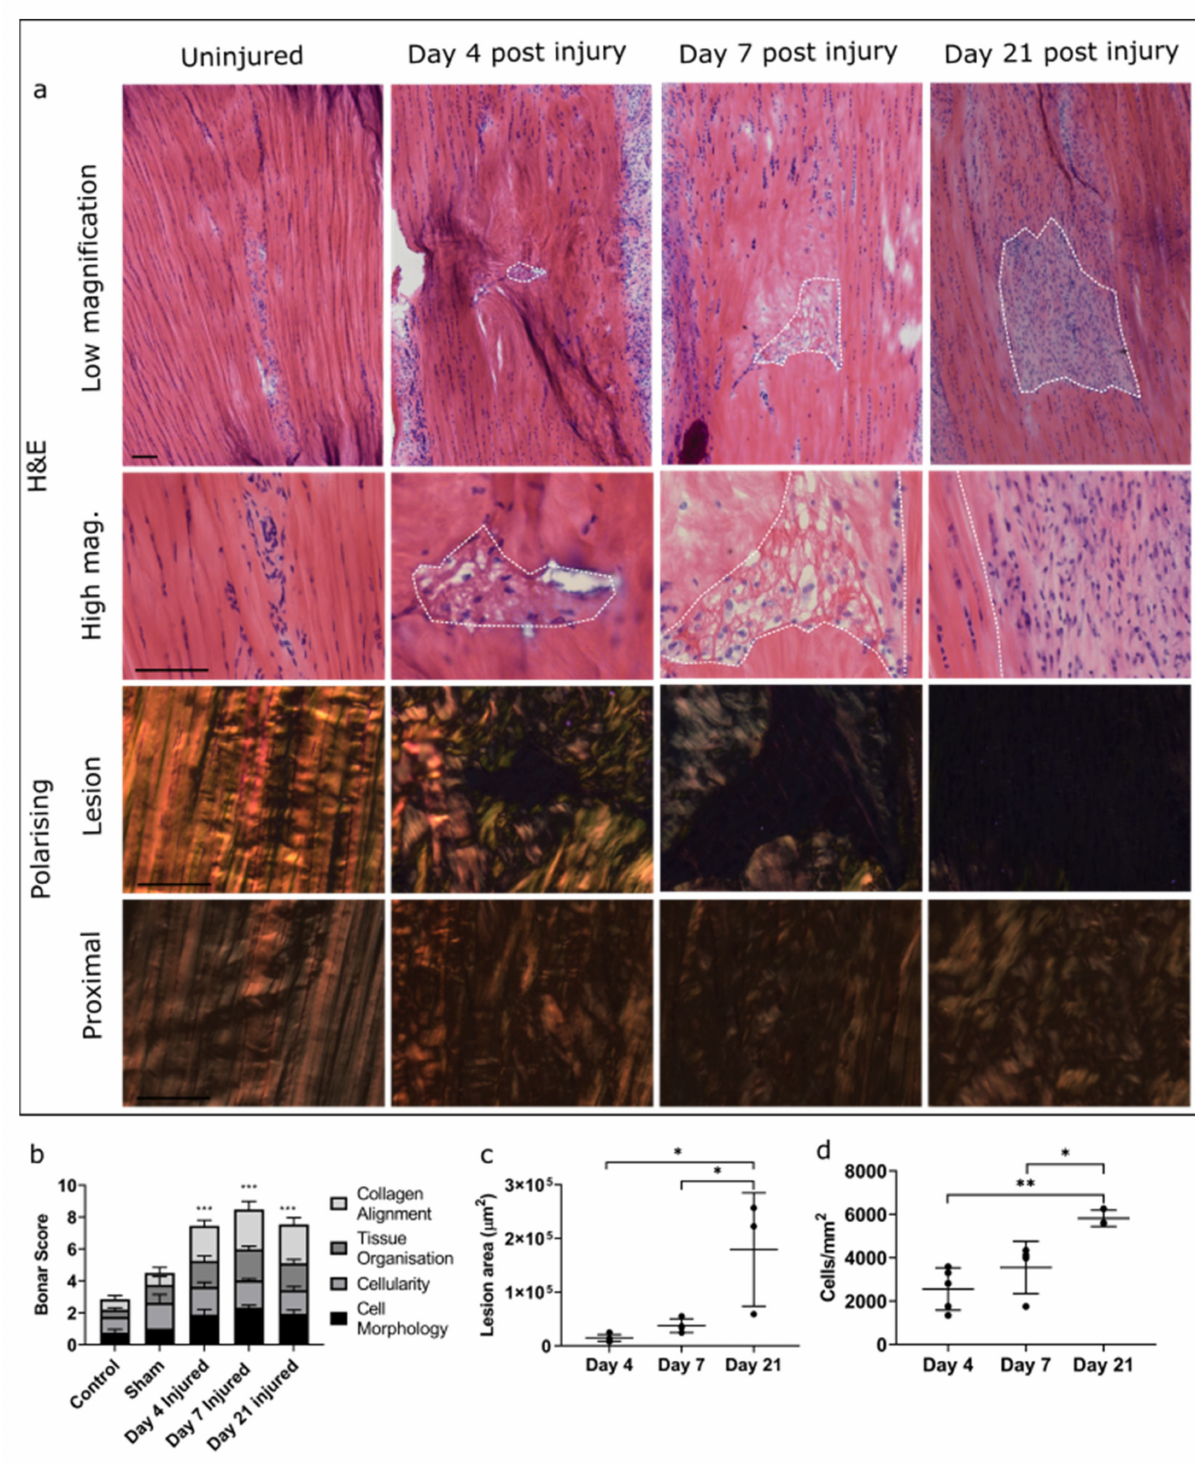
Figure 1. Effect of injury on tendon morphology and cellularity. H&E stained tendon sections visualised under bright and polarising microscopy demonstrate alterations in lesion appearance over time in injured tendons compared to contralateral controls. Lesions are outlined by dotted lines. Alterations in collagen organisation were also observed up to 500 µ m proximal to the lesion. Scale bar = 100 µ m ( a ). Scoring was based on the Bonar scoring system and demonstrated a significant increase in overall score in injured compared to control and sham samples (indicated by ***), but no difference between injury time points ( b ). Lesion area ( c ) and cellularity ( d ) were significantly greater at day 21 than at day 4 or day 7. Data are displayed as mean ± S.D; n = 4 per time point. Significance indicated by *: * = p < 0.05, ** = p < 0.01, *** = p <